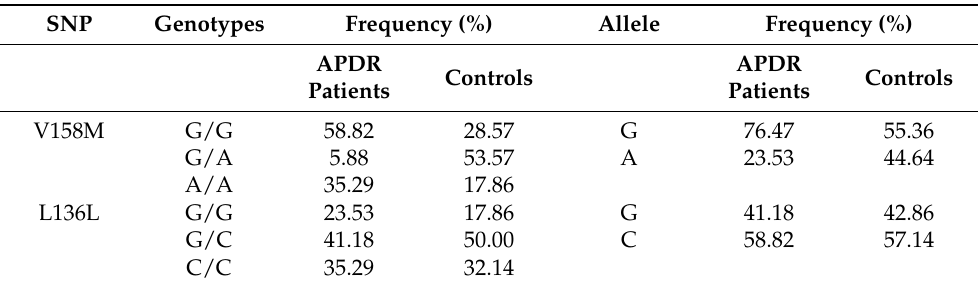
Table 3. Genotype and allele frequencies of V158M (rs4680) and L136L (rs4818) polymorphisms in COMT gene of APDR patient ( n = 17) and control group ( n = 56).